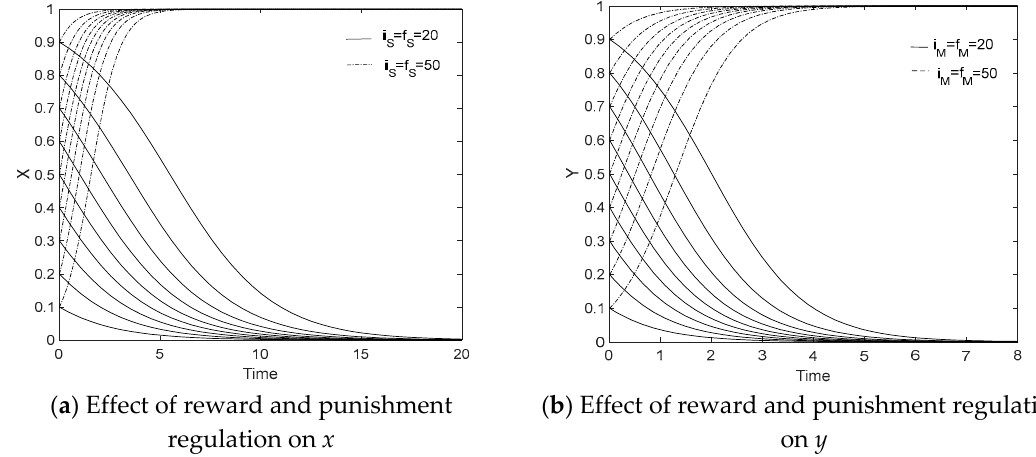
Figure 8. Effect of reward and punishment regulation on strategies of suppliers and manufacturers. Figure 8. E ff ect of reward and punishment regulation on strategies of suppliers and